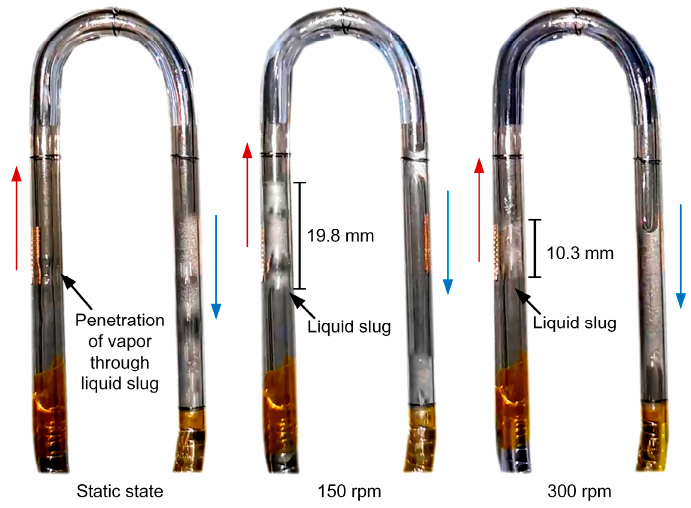
ff erent rotating speeds (heat flux of 22,750 W / m 2